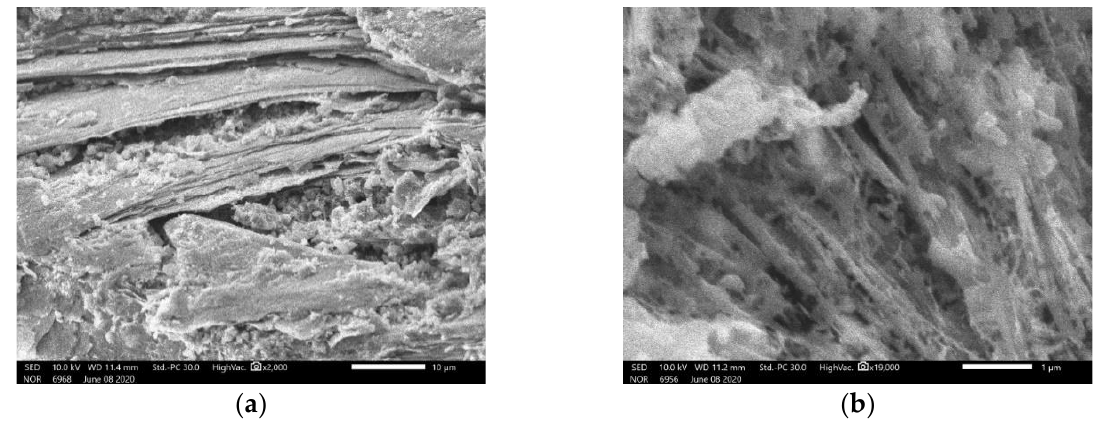
Figure 16. ( a ) Geopolymer gel with fiber form (specimen cured at 60 °C); ( b ) a zoom at 1 µm.